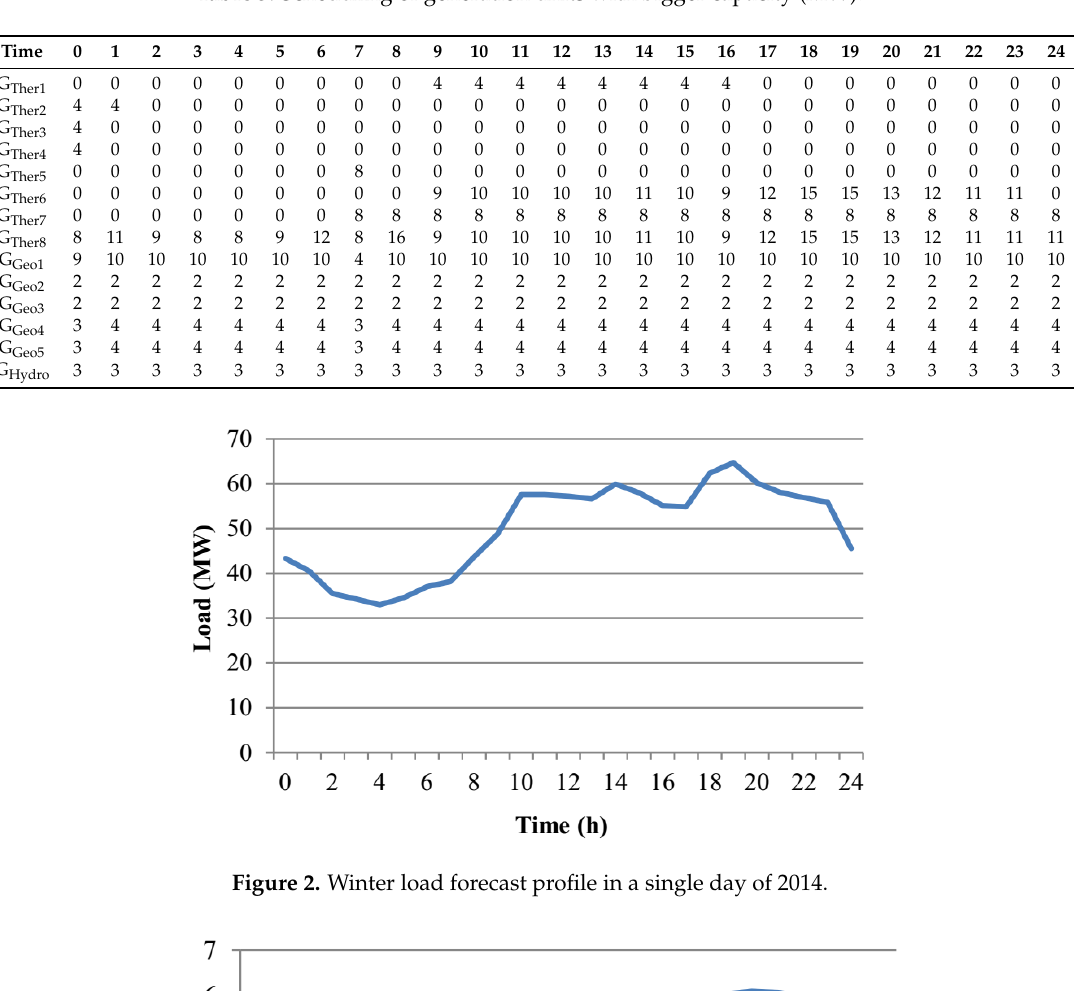
Table 3. Scheduling of generation units with bigger capacity (MW).